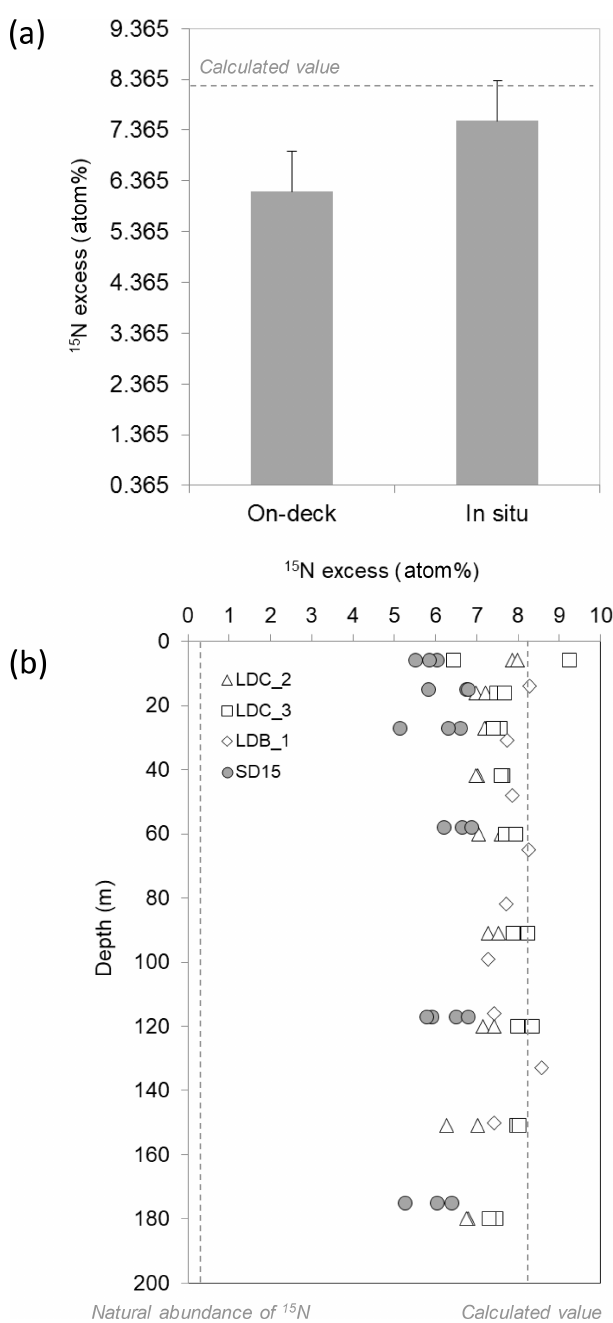
Figure 3. (a) The average measured 15 N / 14 N ratio of the N 2 pool in the incubation bottles incubated either in on-deck incubators ( n = 54) or in situ (mooring line) ( n = 44). The dashed lines rep- resent the theoretical value ( ∼ 8.2at.%) calculated assuming com- plete isotopic equilibration between the gas bubble and the seawater based on gas constants. Error bars represent the standard deviation (b) depth profiles of the 15 N / 14 N ratio of the N 2 pool in the in- cubation bottles incubated either in on-deck incubators (filled sym- bols) or on an in situ mooring line (open